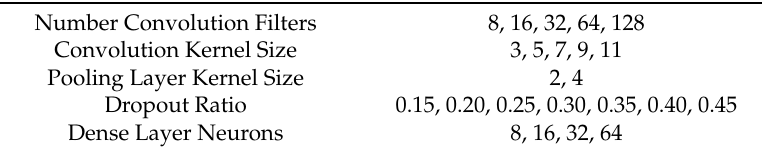
Table 3. Hyper-parameter tuning